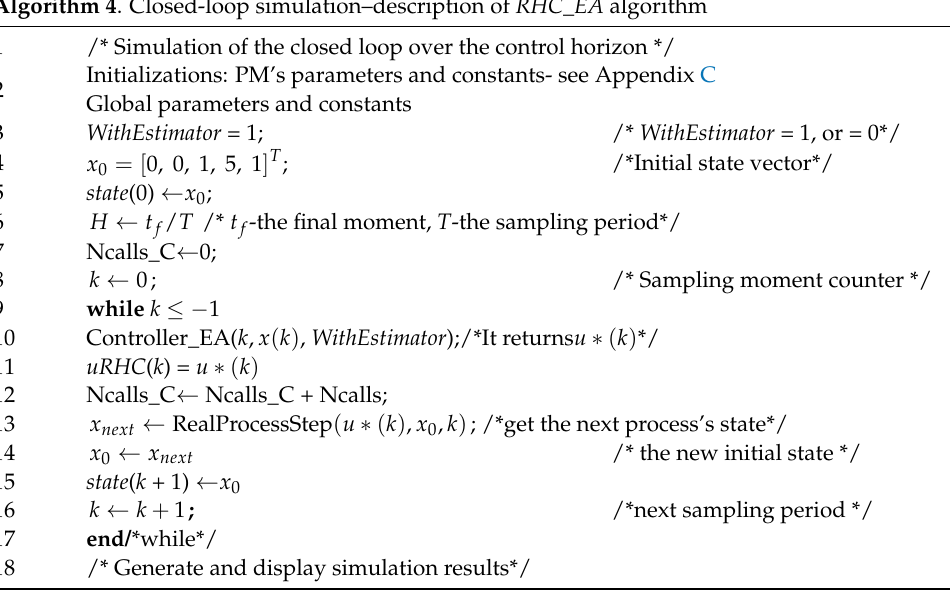
Algorithm 4 . Closed-loop simulation–description of RHC_EA